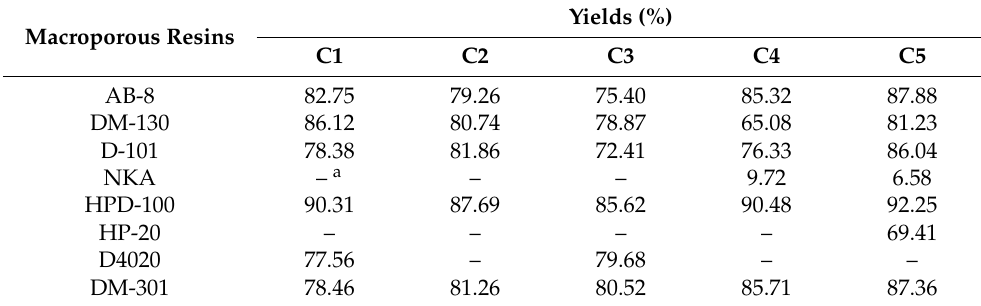
Table 5. Recovery yields of the five target macamides from the